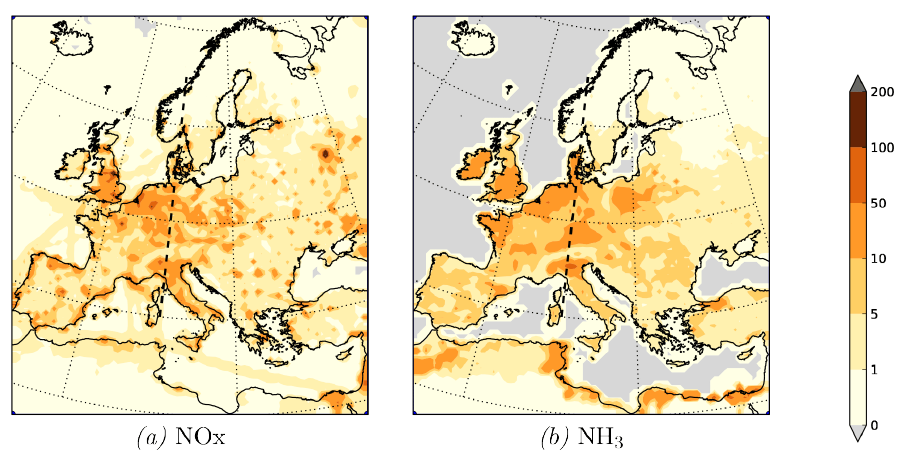
Figure 1. Emissions of NO x and NH 3 for the 2005 base year. Unit: kg ( N ) ha − 1 . Also indicated is the transect line through 10 ◦ E used in Figs. 4, 8 and 9.